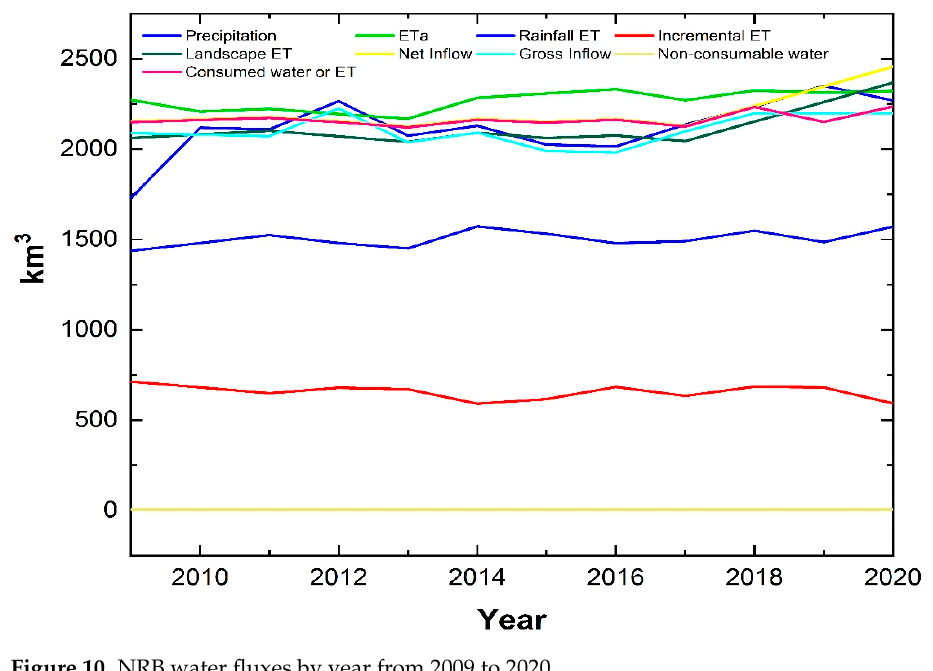
Figure 10. NRB water fluxes by year from 2009 to 2020.